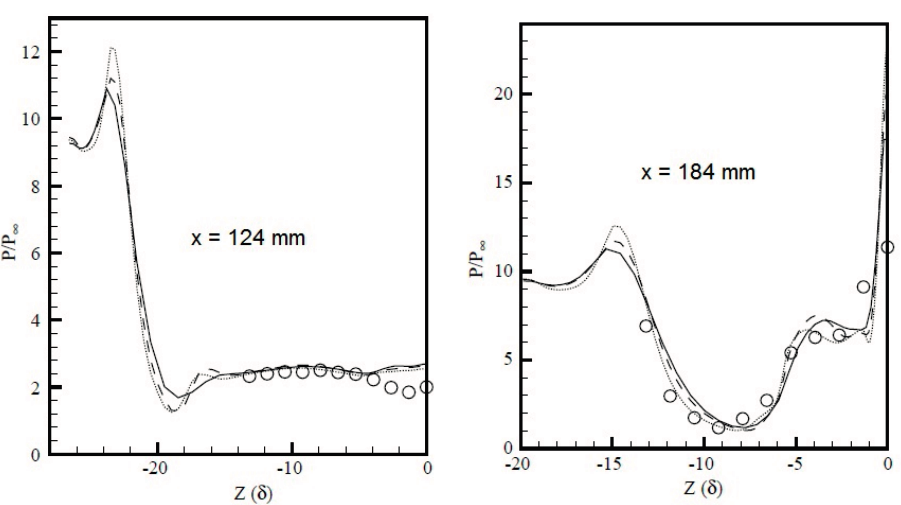
Figure 10. Wall pressure prediction of Schmisseur and Gaitonde